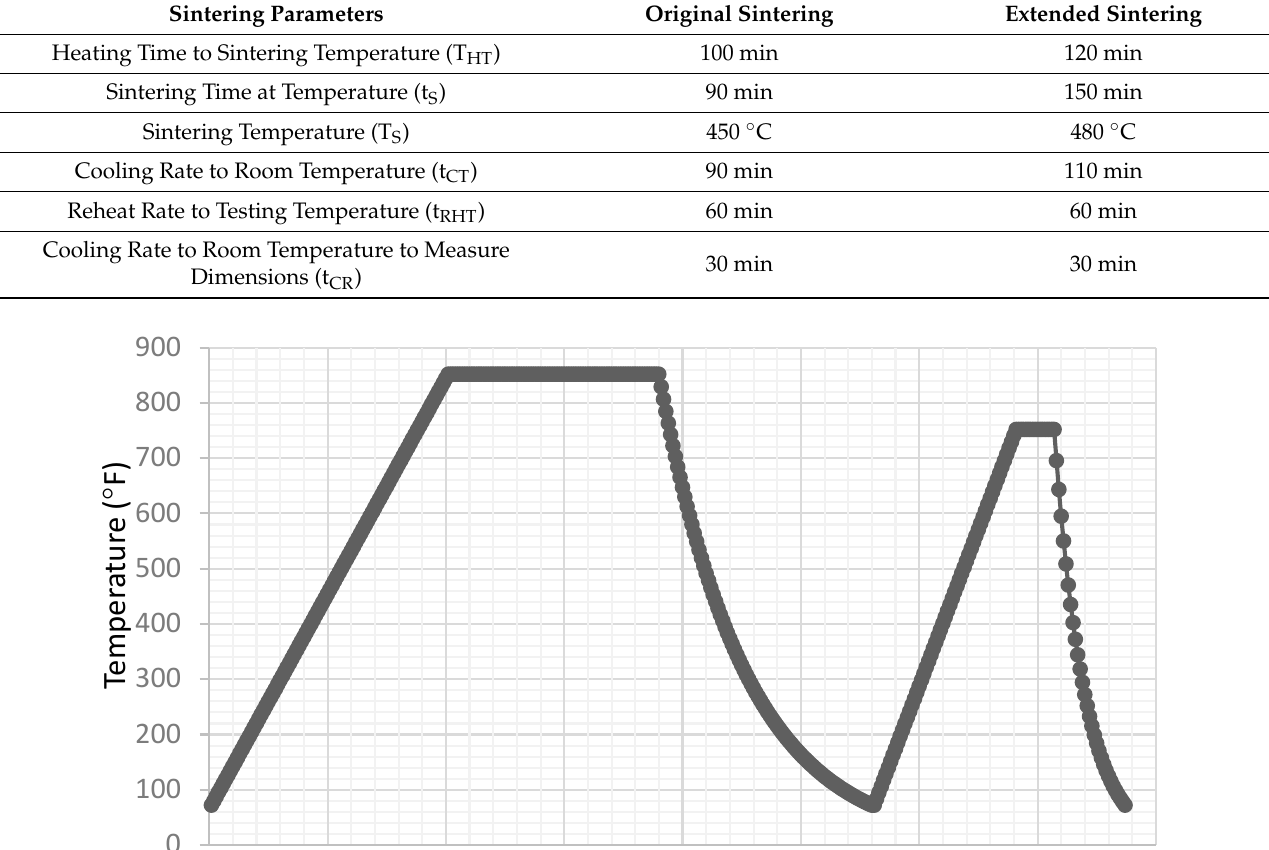
Table 2. Sintering Parameters.